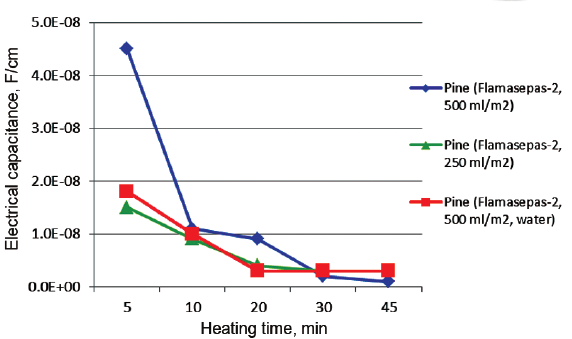
fig. 5. the dependency of the average electrical capacitance on heating time for media 6, 7 and 8